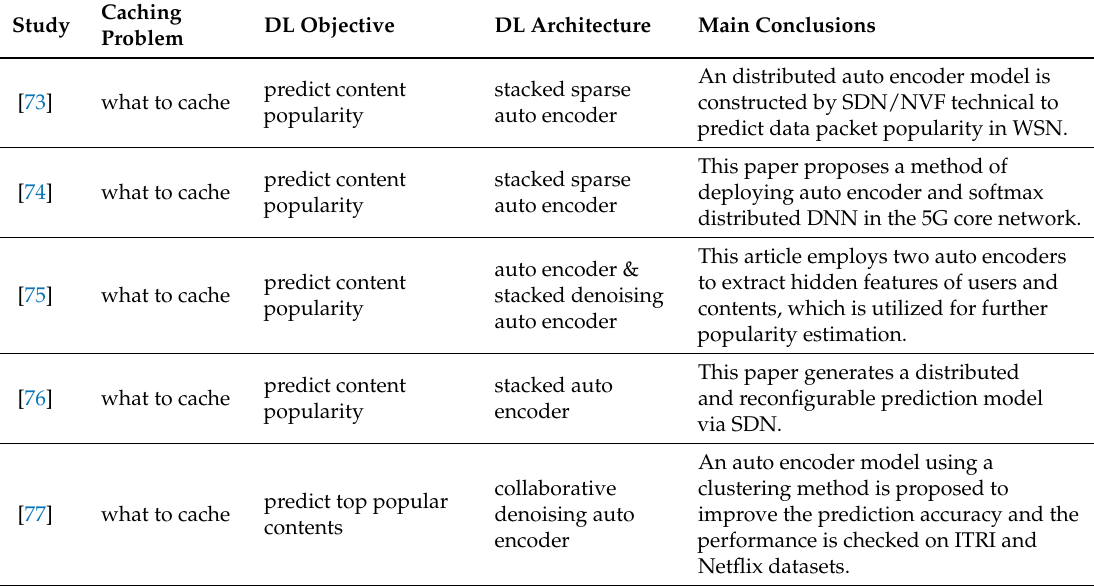
Table 5. Summary of auto encoder for data caching.